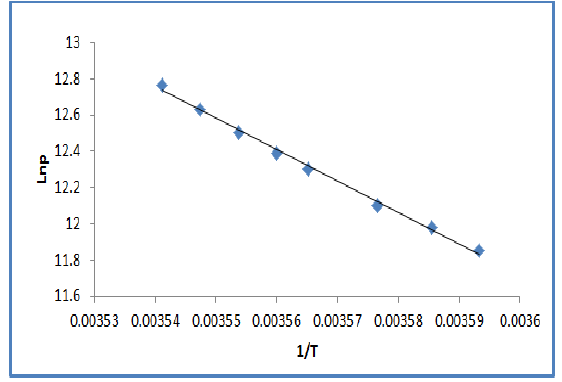
Fig. 11. dissociation data of R134 hydrate, represented by ln P vs. 1/Tplot.